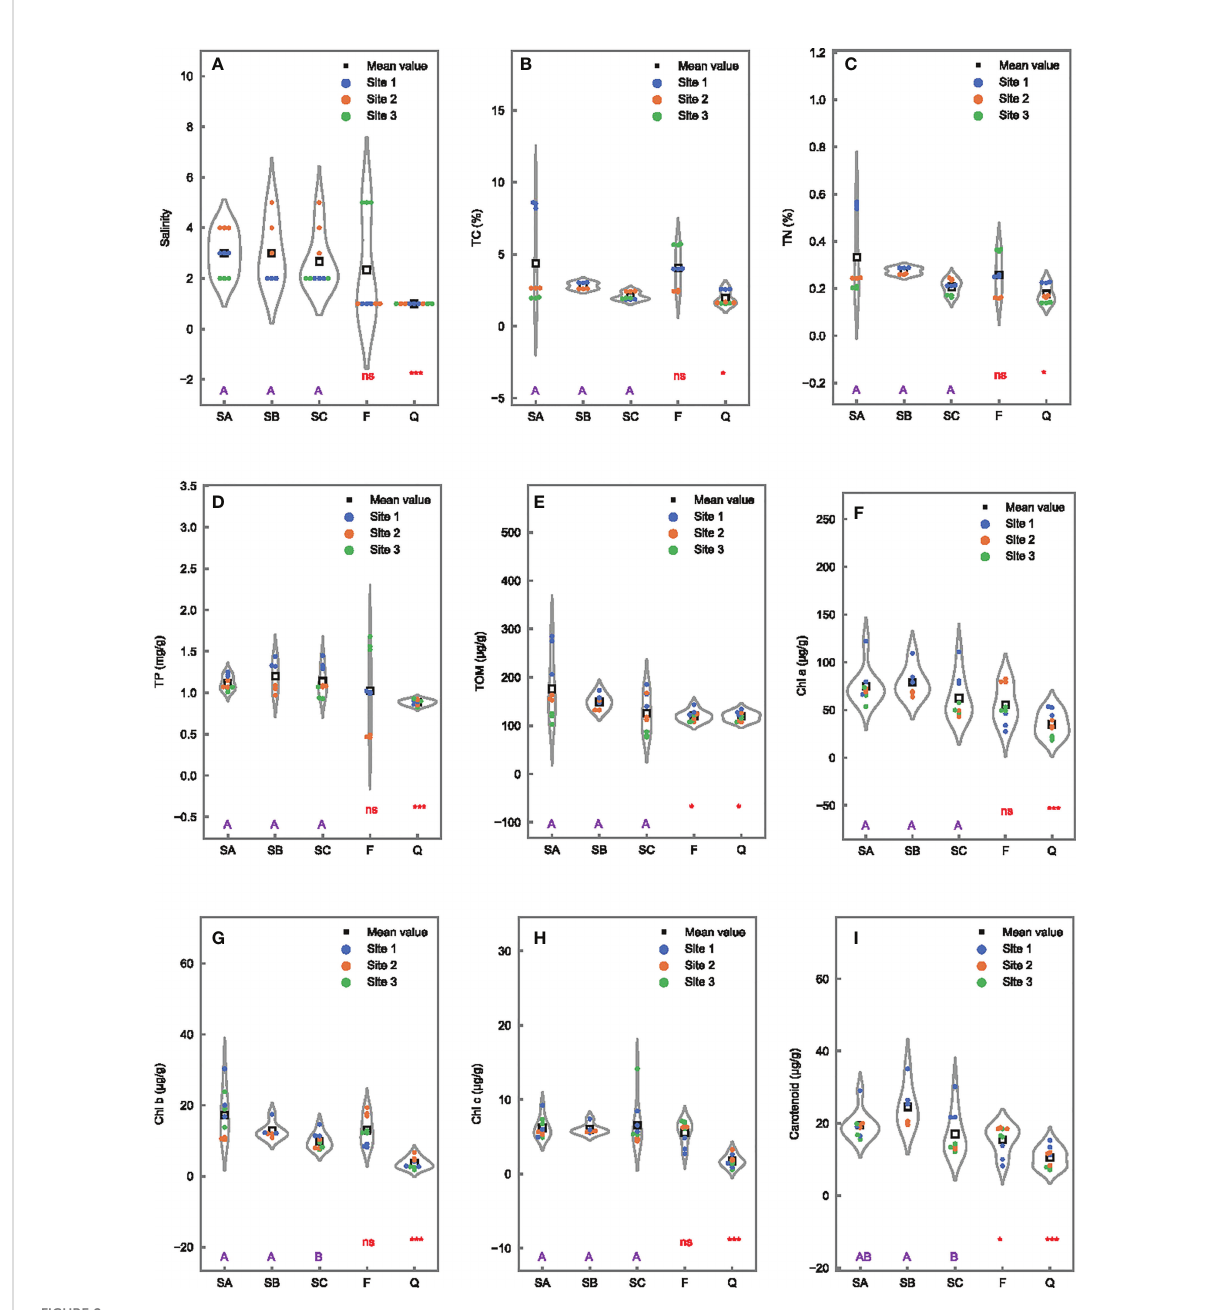
FIGURE 2 Differences of properties in 0- to 1-cm surface sediments among tidal levels in Futian (SA, SB, and SC), between sampling times (SA vs. F), and between Futian and Qi ’ ao wetlands (SA vs. Q). Different letter shows signi fi cant differences among tidal levels at p < 0.05 according to one-way ANOVA, while * and *** indicate signi fi cant differences between times, as well as between mangrove wetlands at p < 0.05, and 0.001, respectively, ns indicates not signi fi cant difference, according to Student ’ s t -test: (A) salinity; (B) TC; (C) TN; (D) TP; (E) TOM; (F) Chl a; (G) Chl b; (H) Chl c; and (I)